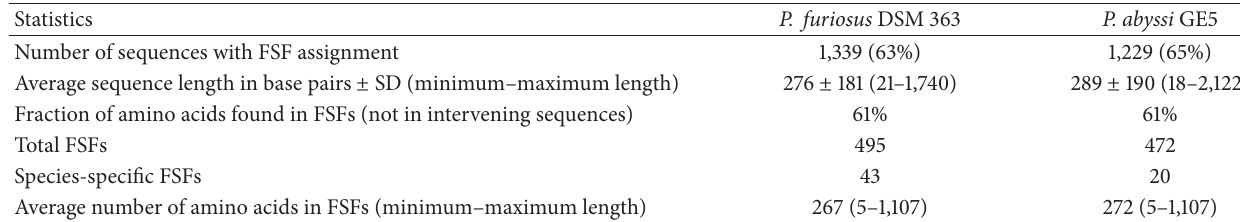
Table 1: Protein sequences and FSF domain